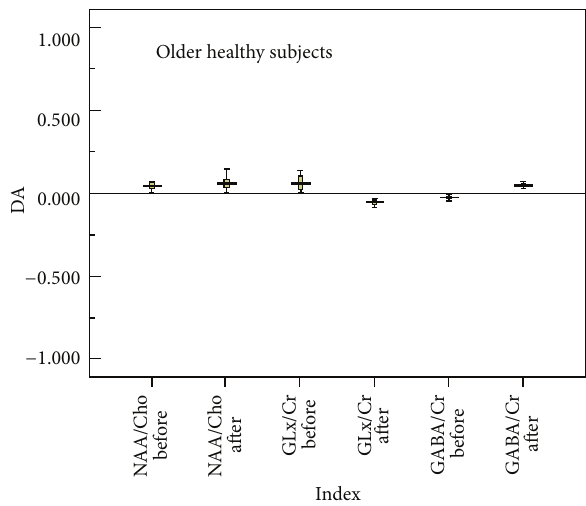
Figure3:Schematicdiagramofasymmetryofleftandrightauditory cortical metabolites in the young group before and after pure tone stimulation. Degree of asymmetry > 0 indicates that the content of the auditory cortical metabolite on the left side is higher than that on the right side, whereas degree of asymmetry < 0 indicates that the content of the auditory cortical metabolite on the right side is higher than that on the left side. Abbreviations: DA, degree of asymmetry; Cho, choline-containing compounds; Cr, creatine- containing compounds; Glx, glutamine/glutamate; NAA, N-acetyl- aspartate.